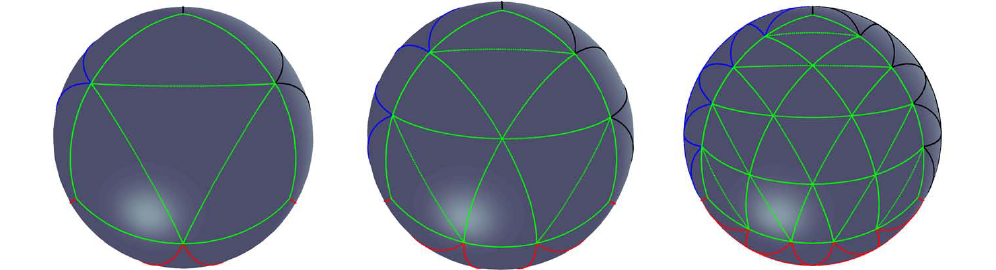
Figure 9. The UV-isogrid ∆ λ =